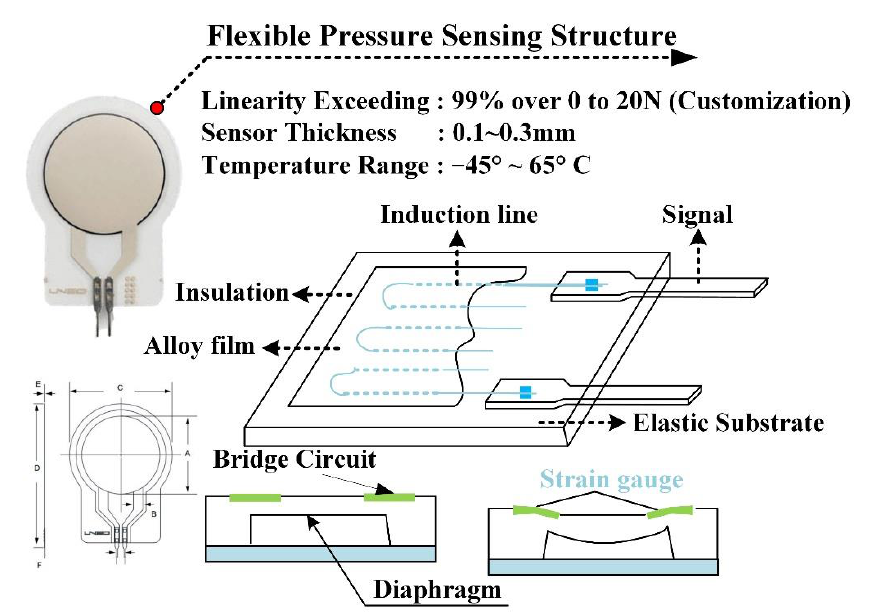
Figure 2. Structural representation of the flexible thin film pressure sensor.